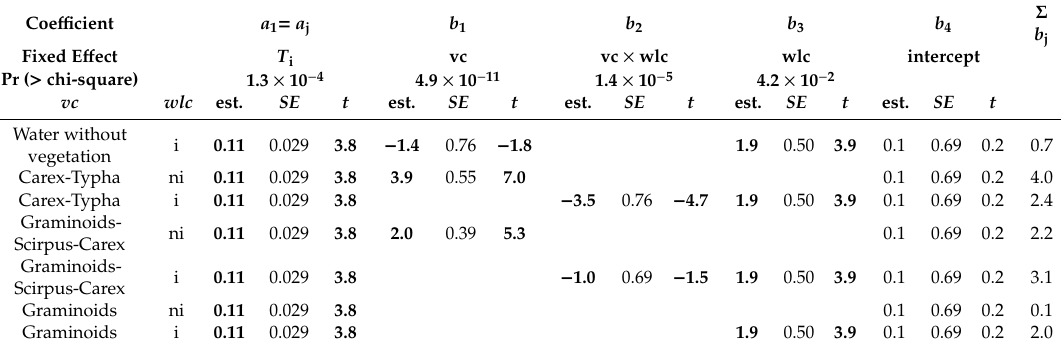
Table 3. Parameters of the linear mixed e ff ects model for CH 4 fluxes to the atmosphere from the vegetation communities. Significant fixed e ff ects and coe ffi cients in bold. Reference level for vegetation community: graminoids; reference level for water level category: non-inundated. T i = soil / water temperature; vc = vegetation community; wlc = water level category; i = inundated; ni = non-inundated; est. = estimate; SE = standard error; t = t value. Random e ff ect’s intercept b 5 = ± 0.5 (standard deviation SD = 0.74) adapting for measurement positions on ( + ) or between ( − ) plant